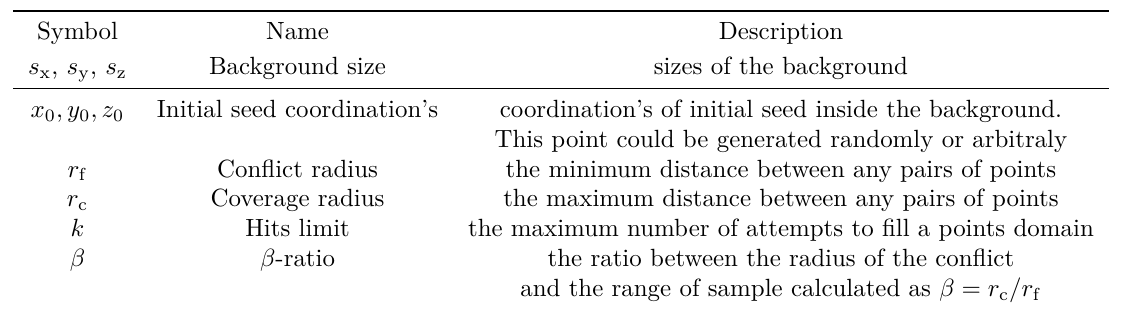
Table 1. List of initial parameters for spatial points cloud generator